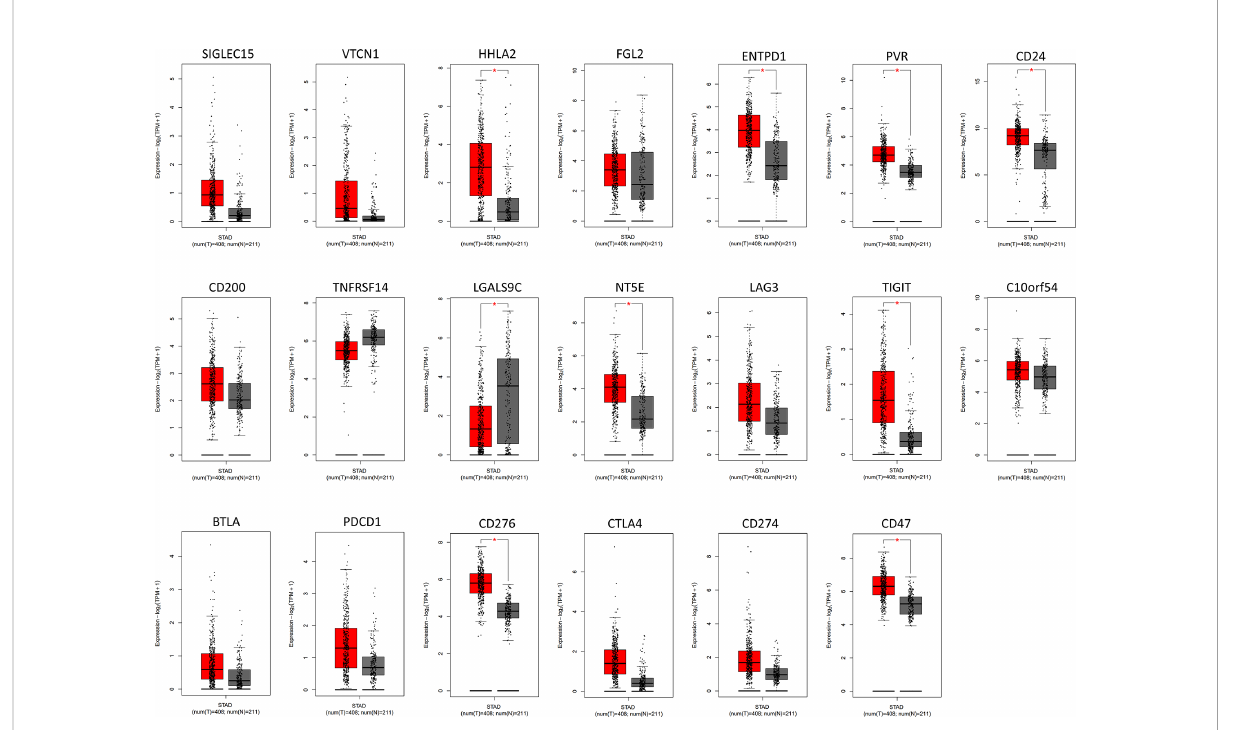
FIGURE 1 The analysis of immune checkpoint-related genes expression in GC by GEPIA database. The results revealed that 9 genes were con fi rmed to have signi fi cant differential expression in GC compared to the normal tissues. Among them, higher expression was observed in HHLA2, ENTPD1, PVR, CD24, NT5E, TIGIT, CD276, and CD47 and lower expression was observed in LGALS9C. Red color represents tumor tissue (n=408), and gray color represents normal tissue (n=211). STAD, stomach adenocarcinoma. * P <